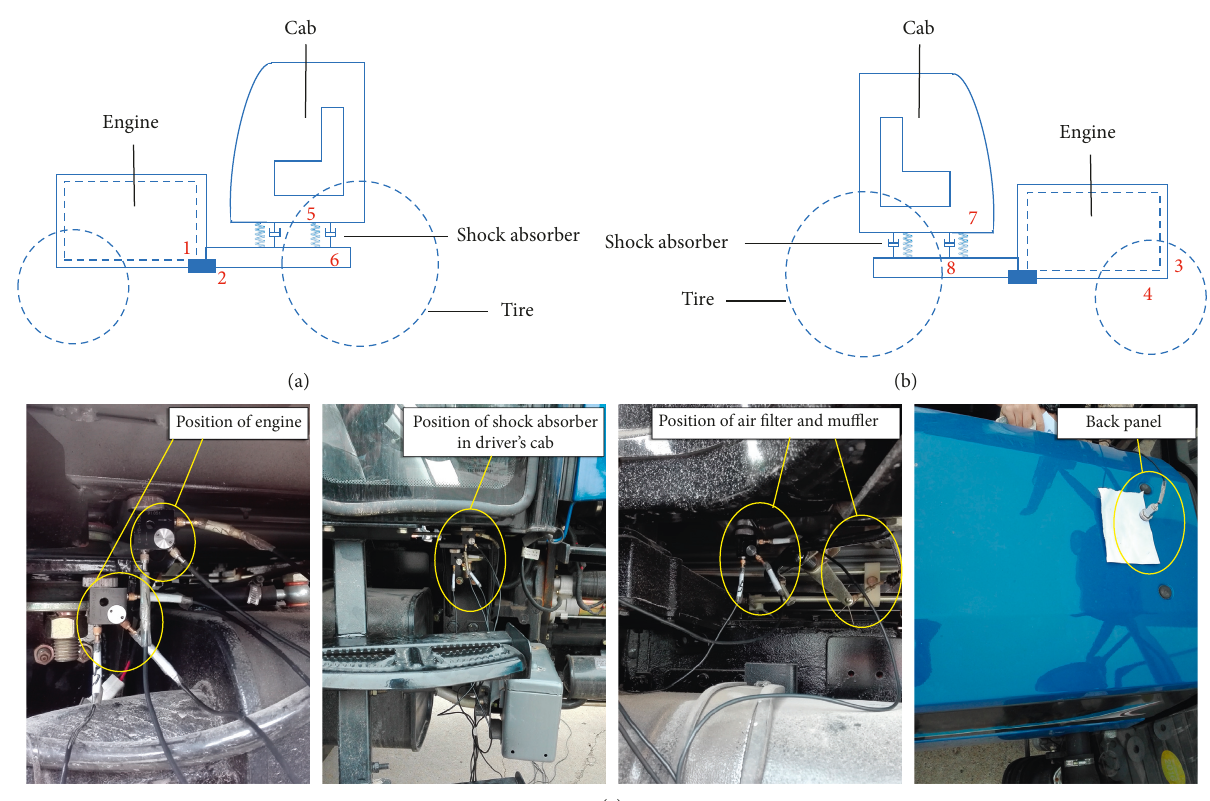
Figure 6: Noise and vibration measurement locations in a test vehicle. (a) Left view of the tractor model frame. (b) Right view of the tractor model frame. (c) Practical on-site test.